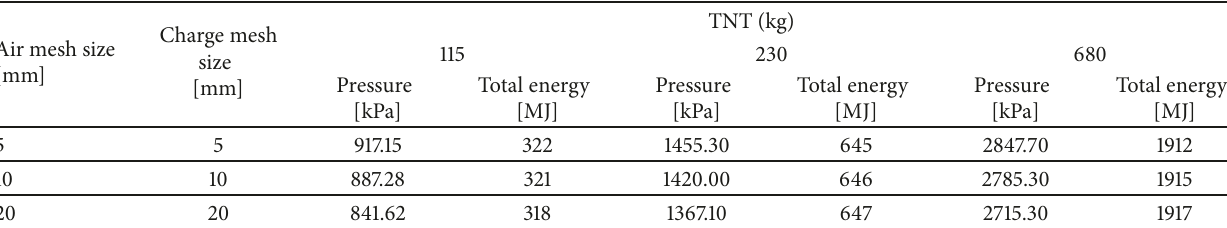
Table 4: Pressure and energy values used for